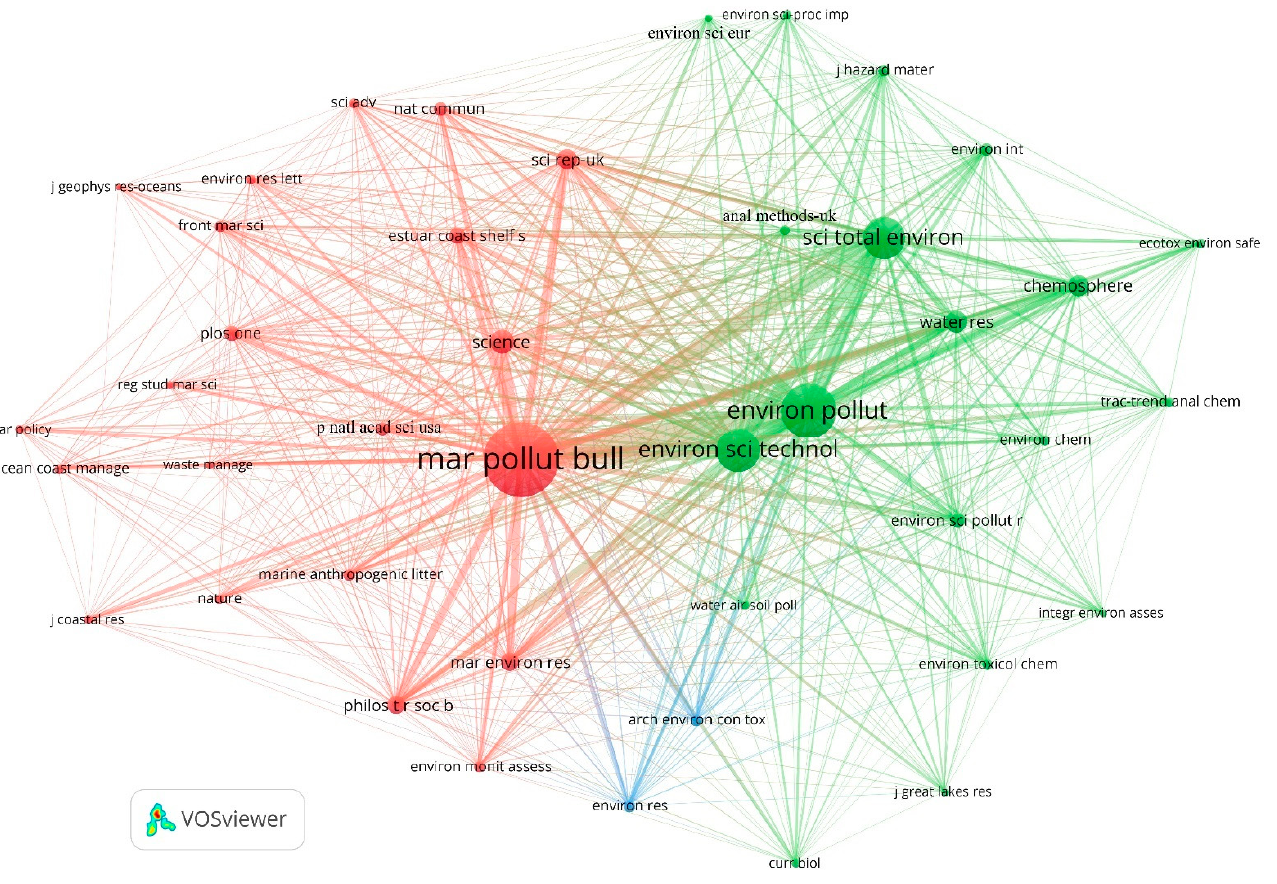
Figure 3. Main publication sources.